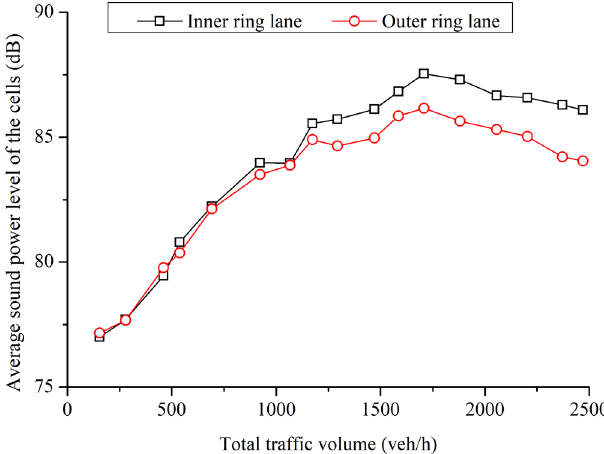
Figure 9. Comparison of the average sound power levels of the cells in the inner ring and the outer